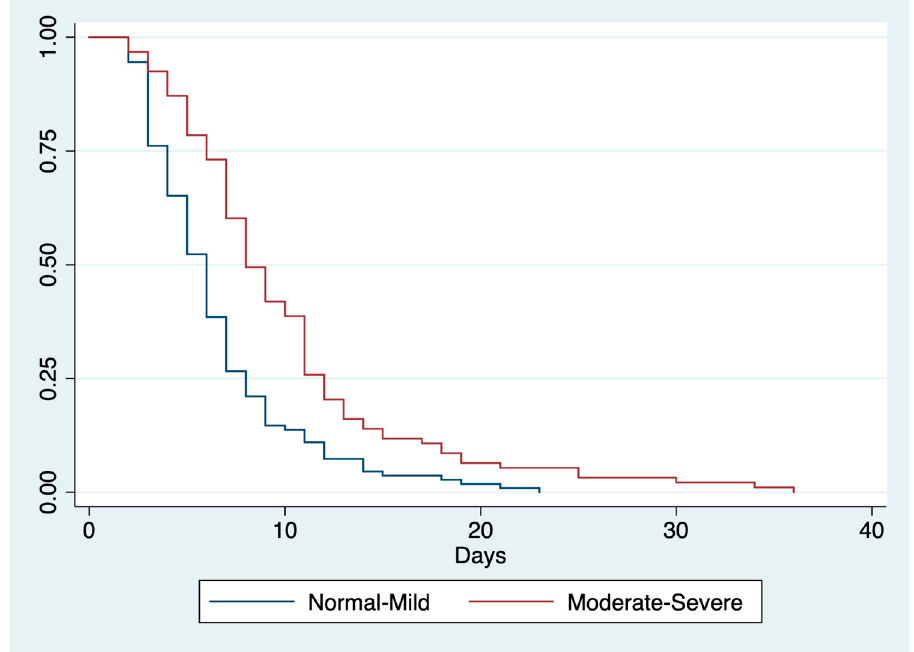
Figure 1. Kaplan–Meier curves for LOS according to CONUT score. Abbreviations: CONUT, controlling nutritional status; LOS, length of hospital stay; log-rank p < 0.0001.